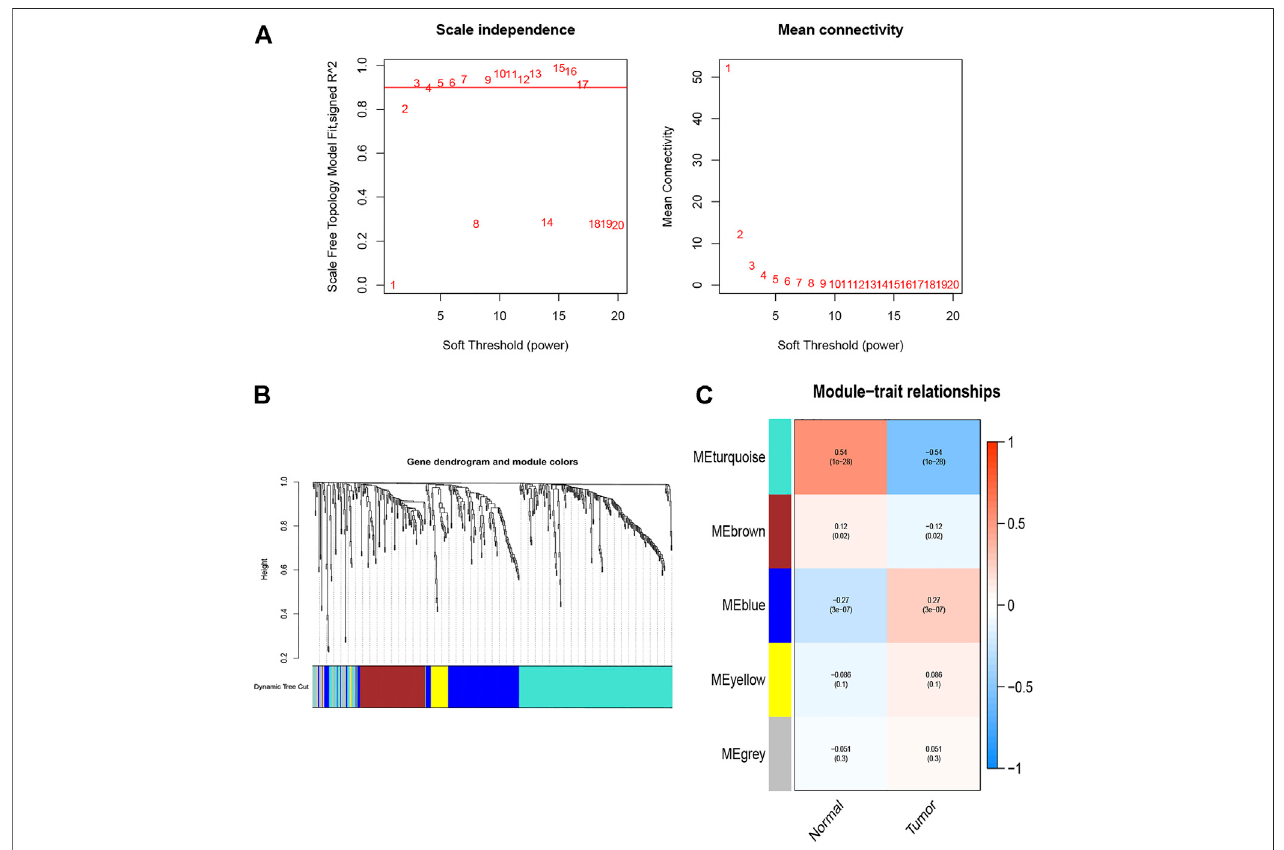
( Figure 1E ). Moreover, the KEGG pathways analysis illustrated that the cytokine – cytokine receptor interaction, viral protein interaction with cytokine and